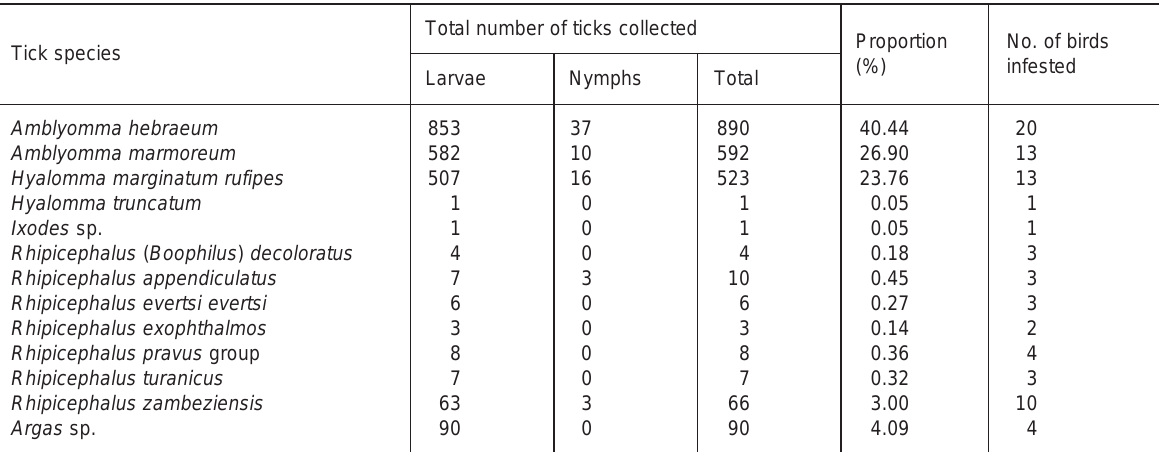
TABLE 1 Ticks collected from 23 crested francolins on the farm “Sandspruit”, Limpopo Province